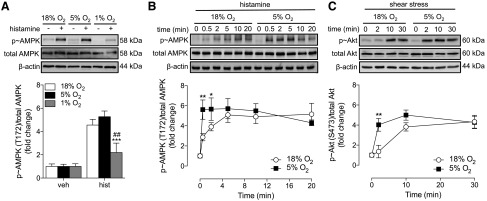
Activation of kinases in HUVECs cultured in various O2 levels. HUVECs were maintained at 18% O2 or cultured in 5 or 1% O2 for at least 5 d. Cells were then stimulated with histamine (10 µM) for 2 min (A) or 0–20 min (B), or laminar shear stress (15 dyn/cm2) for 0–30 min (C). Lysates were immunoblotted for p-AMPK or p-Akt and expressed relative to total kinase levels and β-actin as loading controls. Data are means ± sem (n = 5–6 different donors). Treatment with histamine or shear stress was significant (P < 0.05 vs. respective control) in relevant panels. *P < 0.05, **P < 0.01, ***P < 0.001 vs. 18% O2; ##P < 0.01 vs. 5% O2.